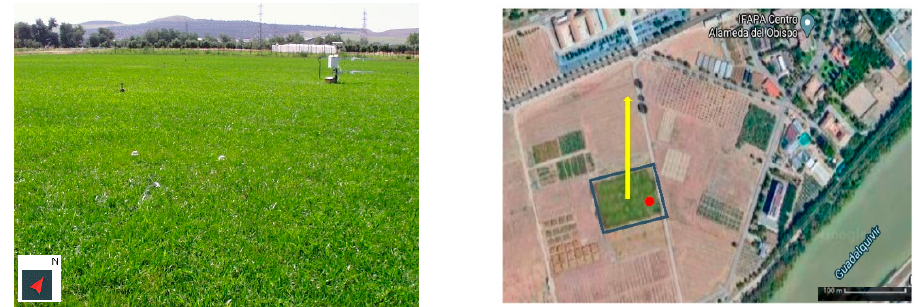
Figure 1. Meteorological station nearby the lysimeter ( left ) and aerial view (Google Maps, 6 February 2021) of the experimental plot (blue rectangle) in the IFAPA center Alameda del Obispo nearby the Guadalquivir river ( right ). The lysimeter and the tower were positioned as indicate the yellow arrow (pointing North) and the red area, respectively.